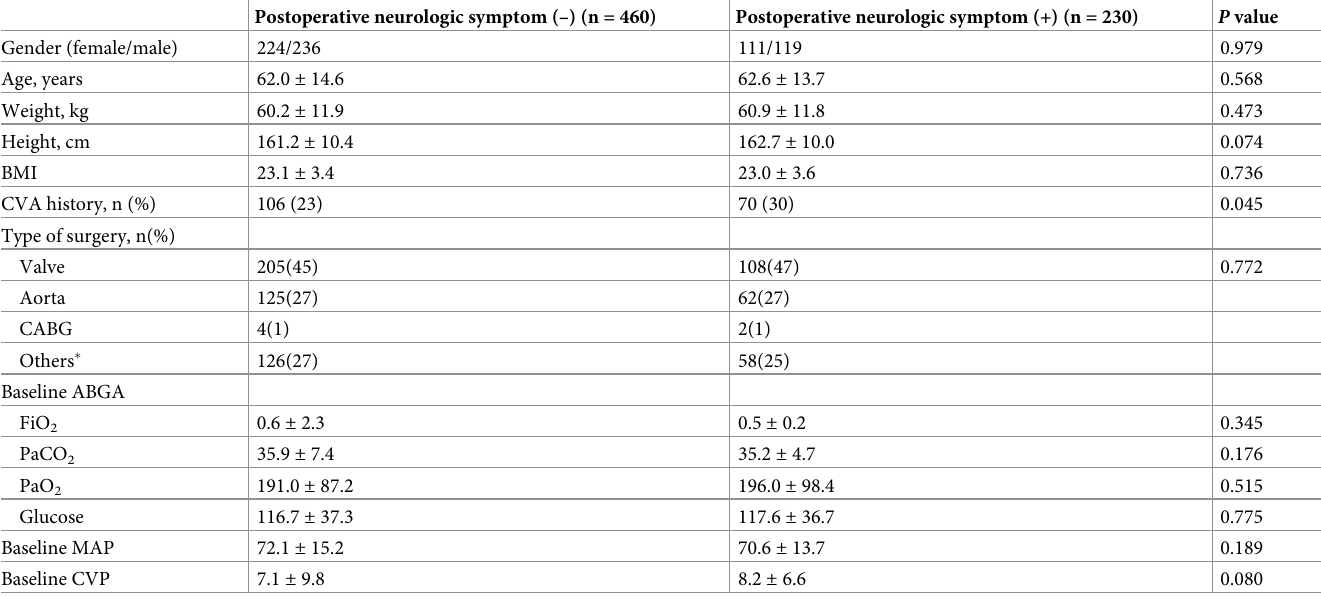
Table 1. Baseline patient